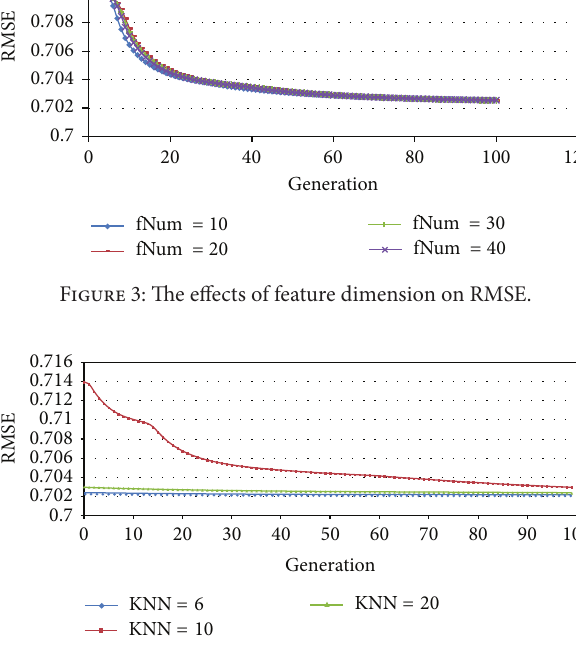
Figure 4: RMSEs of different KNNs.